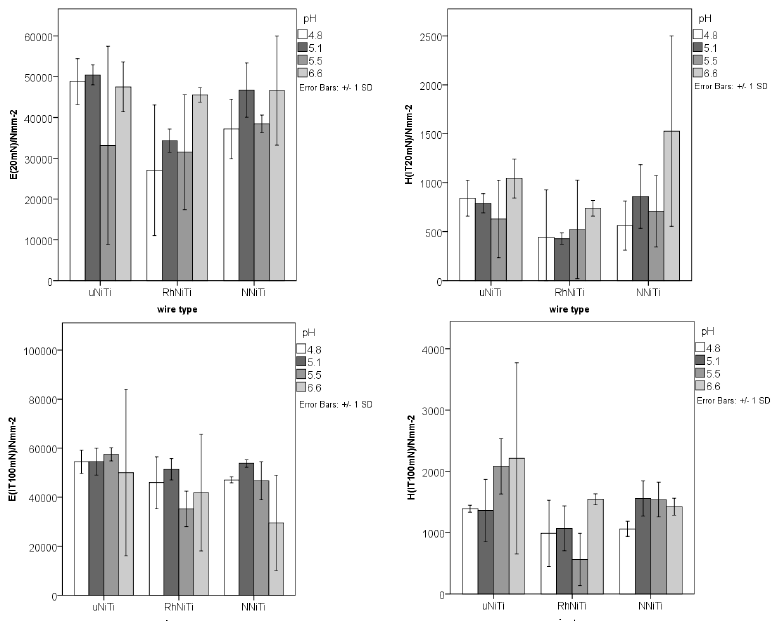
Figure 3. The nanoindentation hardness ( H IT ) and Young’s modulus ( E IT ) values (shown on “y” axes) for the uncoated NiTi (uNiTi), rhodium-coated NiTi (RhNiTi), and nitrified NiTi (NNiTi) wires, after immersion in artificial saliva with four different pH values.